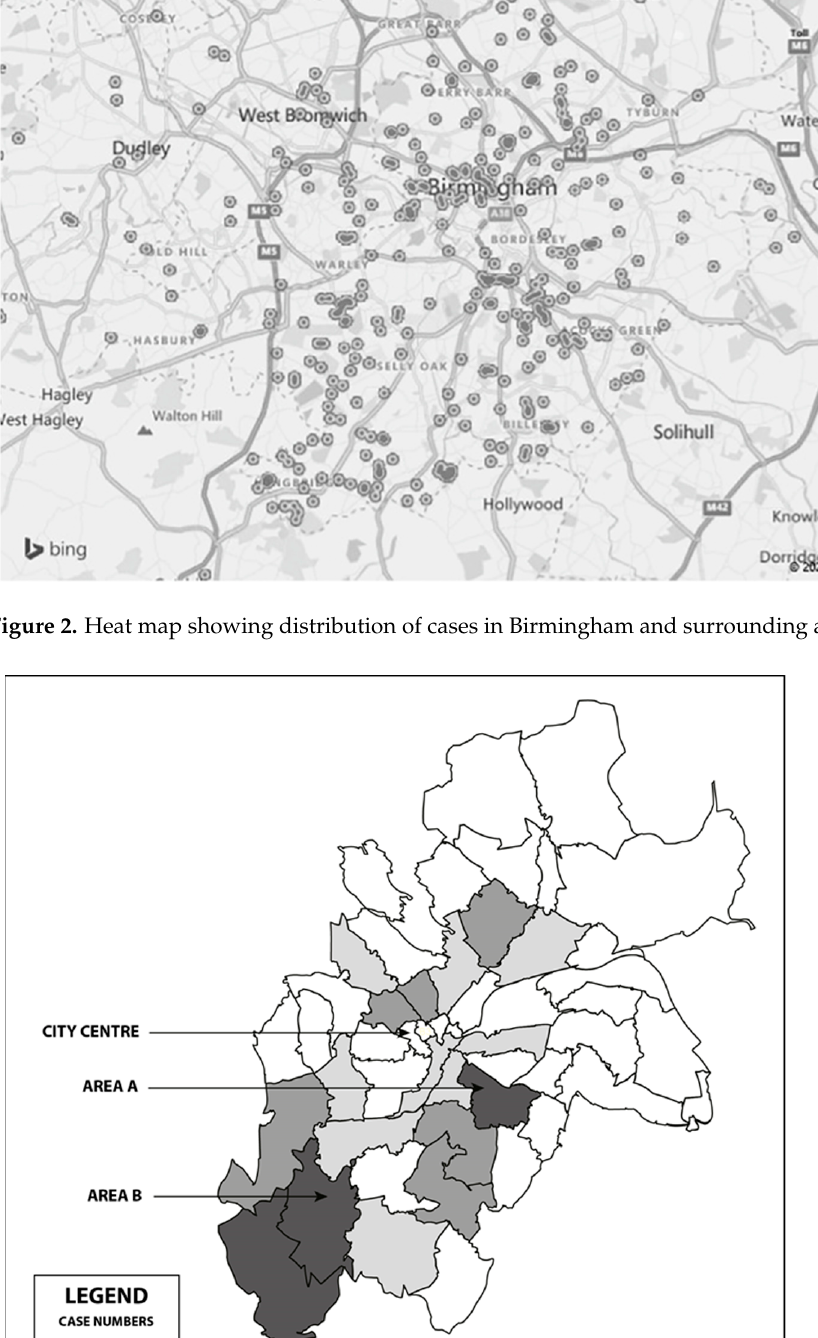
Figure 3. Distribution of cases within Birmingham Postcode areas.